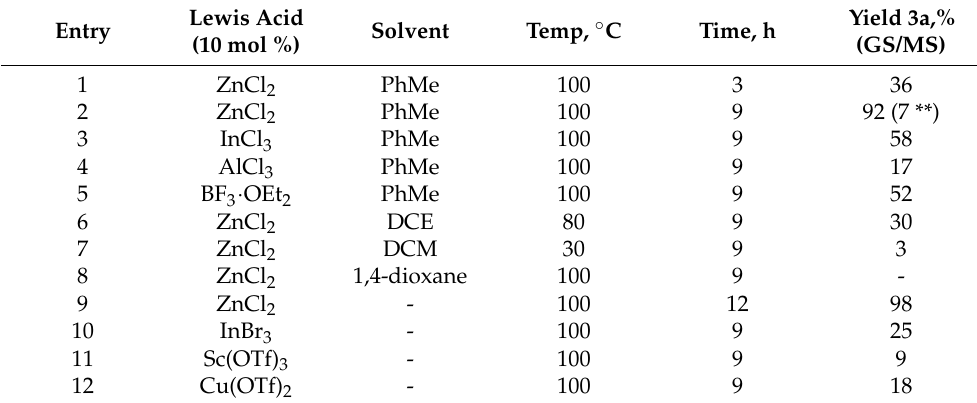
Table 1. The effect of Lewis acid, solvent, and time on the yields 3a * . Lewis Acid Entry